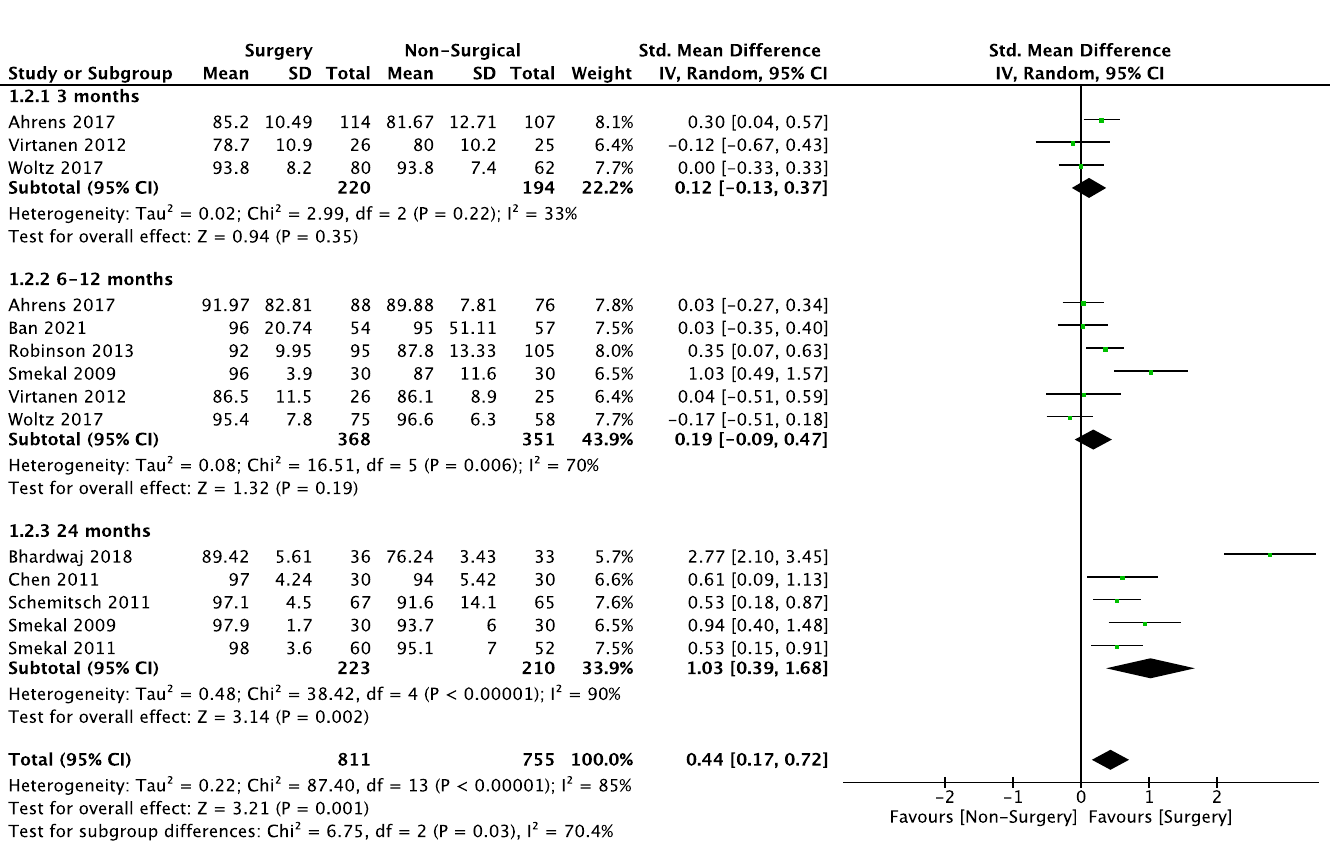
Fig 3. Meta-analysis of overall CMS at � 3 months, 6–12 months and � 24 months between surgical interventions and non-surgical interventions in the pooled studies. Standard-mean difference is 0.44 (95% CI 0.17–0.72; p =